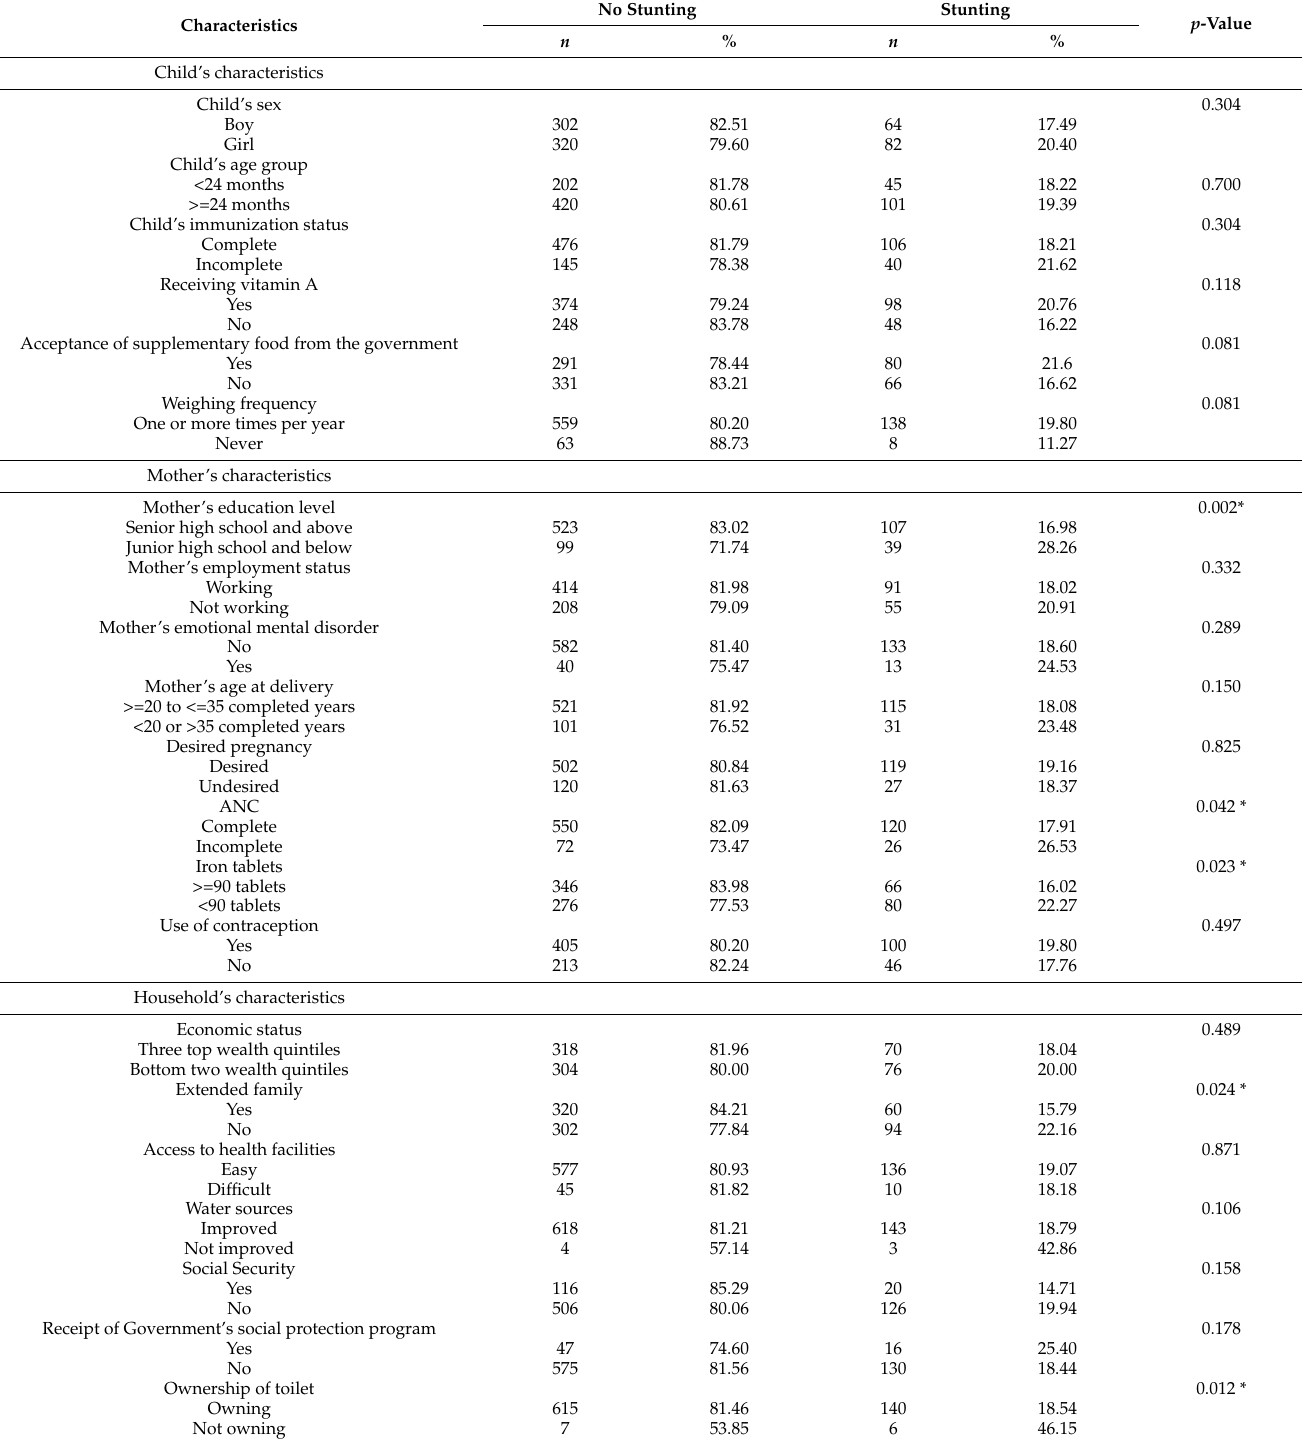
Table 2. Chi-square analysis of the sociodemographic and healthcare factors with stunting status among children aged 6–59 months in Bali Province,